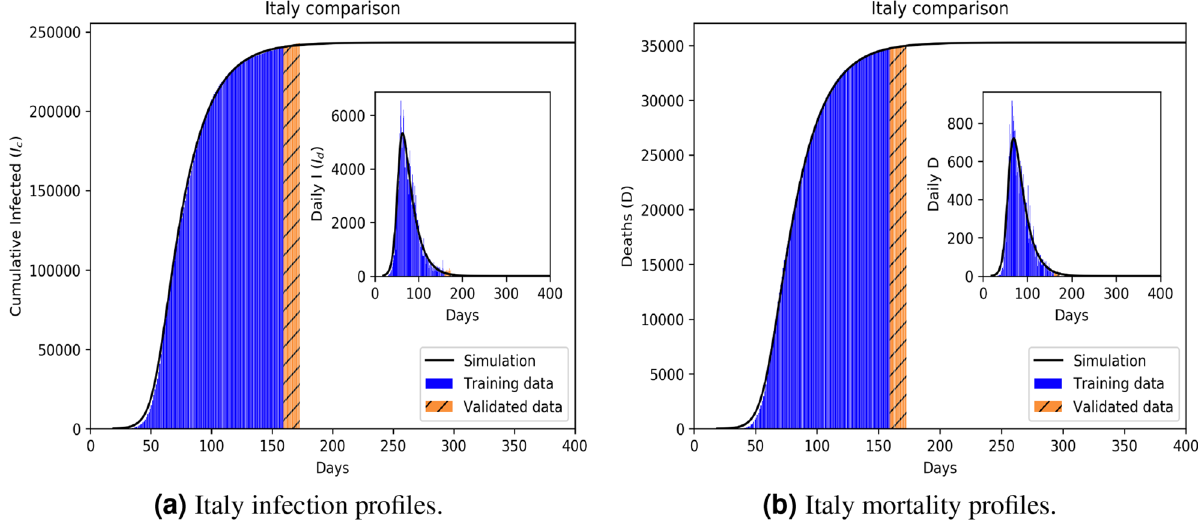
Figure 4. Infection ( a ) and mortality ( b ) epidemiology for Italy (Class C). Outsets represent cumulative statistics while the insets are for daily updates in the number of infected and death respectively. Here “0” marks